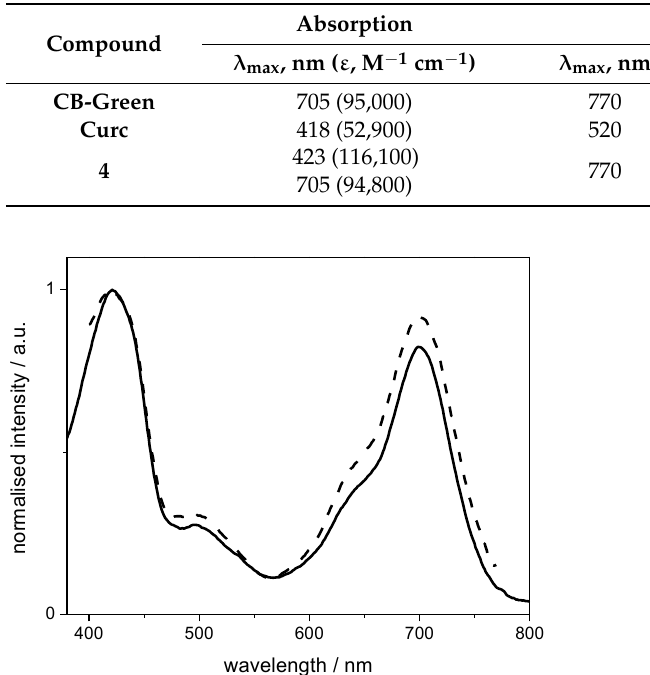
Figure 2. Comparison between the absorption spectrum (solid line) and the excitation spectrum (dashed line) of CB-Green ; the latter was recorded at λ em = 790 nm. Note that the intensity ratio between the maxima at 410 nm and 705 nm remained approximately constant between the absorption and excitation spectra.